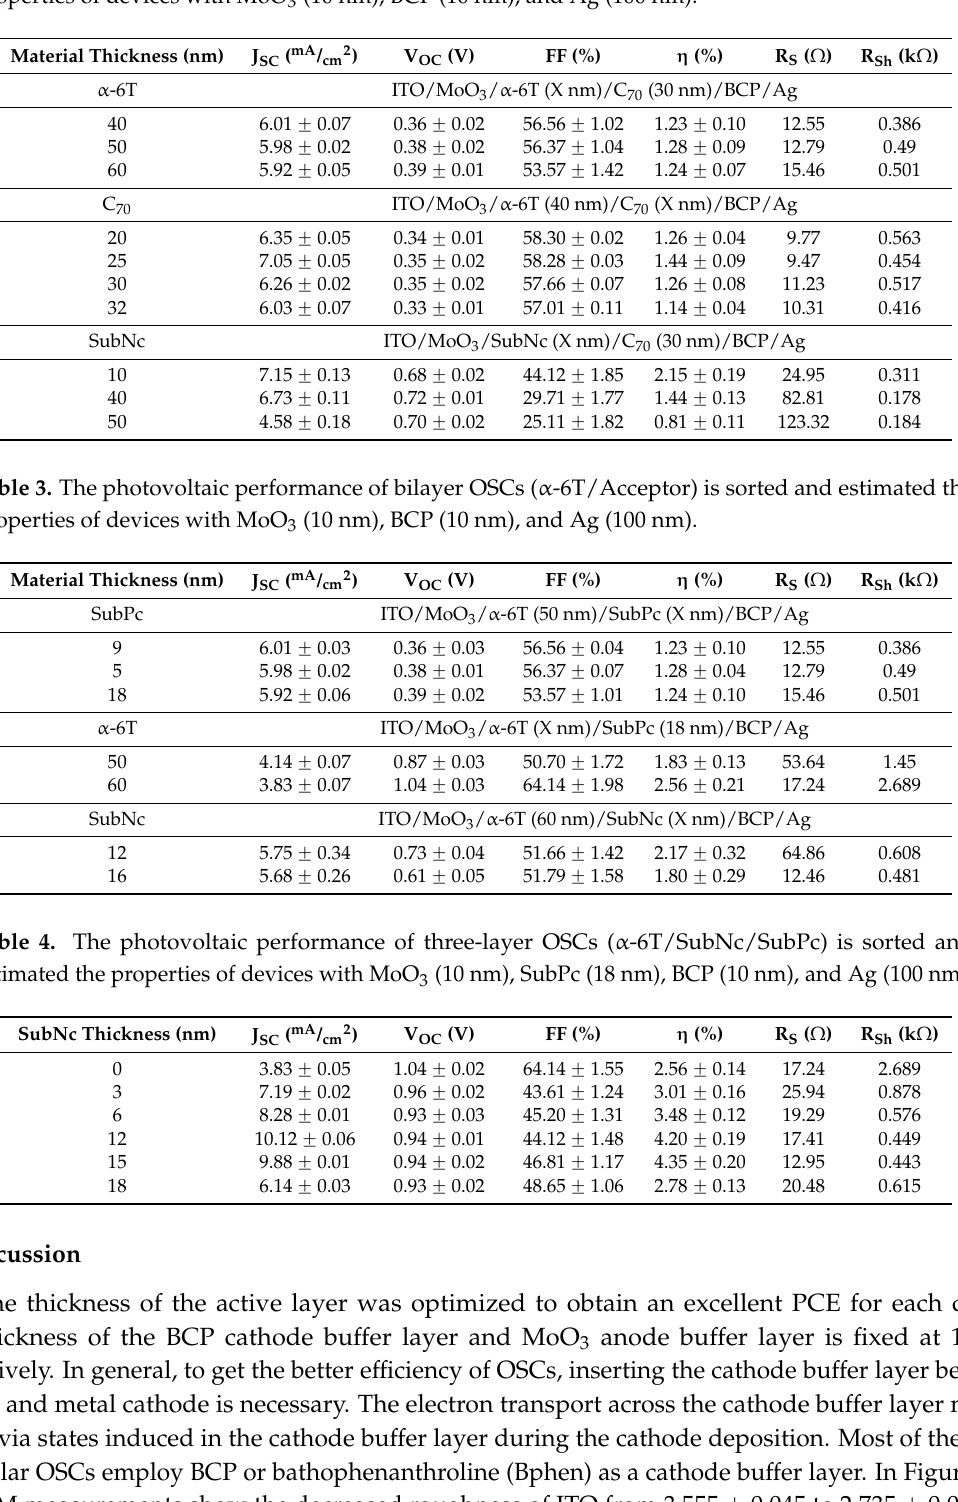
Table 2. The photovoltaic performance of bilayer OSCs ( α -6T/Acceptor) is sorted and estimated the properties of devices with MoO 3 (10 nm), BCP (10 nm), and Ag (100 nm).